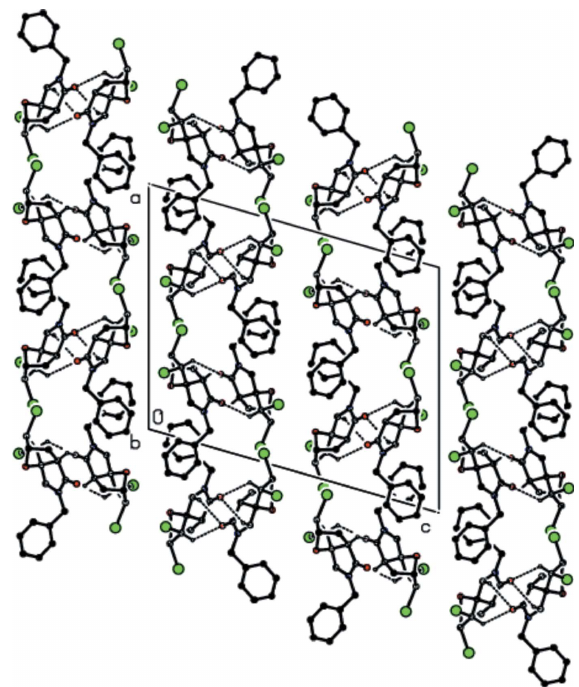
Figure 6 Aview of the three-dimensional Hirshfeld surface for the title compound, plotted over d norm in the range (cid:5) 0.0815 to 0.9926 a.u.